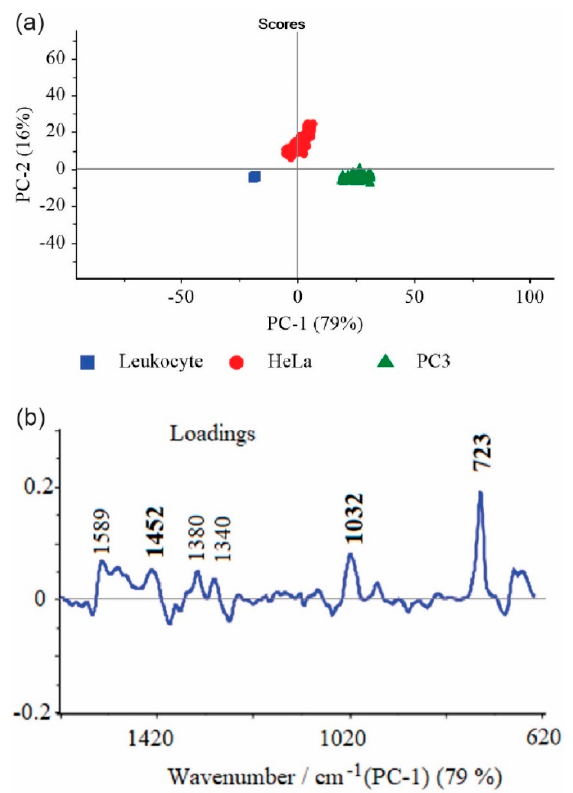
Figure 6. ( a ) The score plots of PC-1 versus PC-2 components for differentiation of leucocyte, HeLa, and PC3 cells. PCA was calculated for the whole region (600–1700 cm − 1 ); ( b ) PC-1 loading